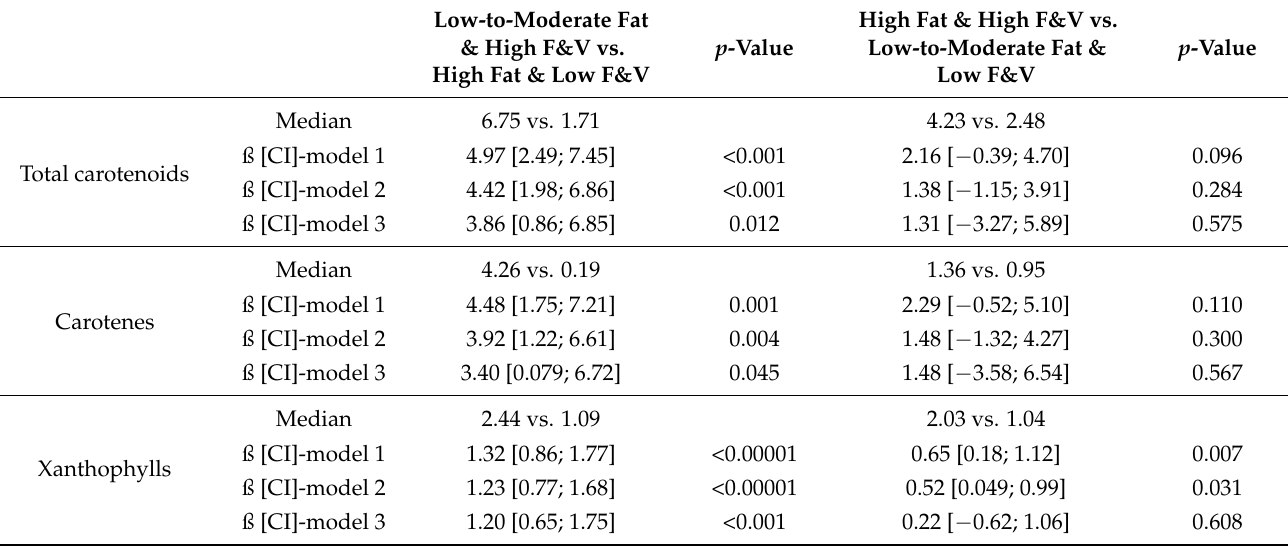
Table 4. Differences in total carotenoid, carotenes and xanthophylls plasma concentrations ( µ mol/L) between extreme groups. Low-to-Moderate